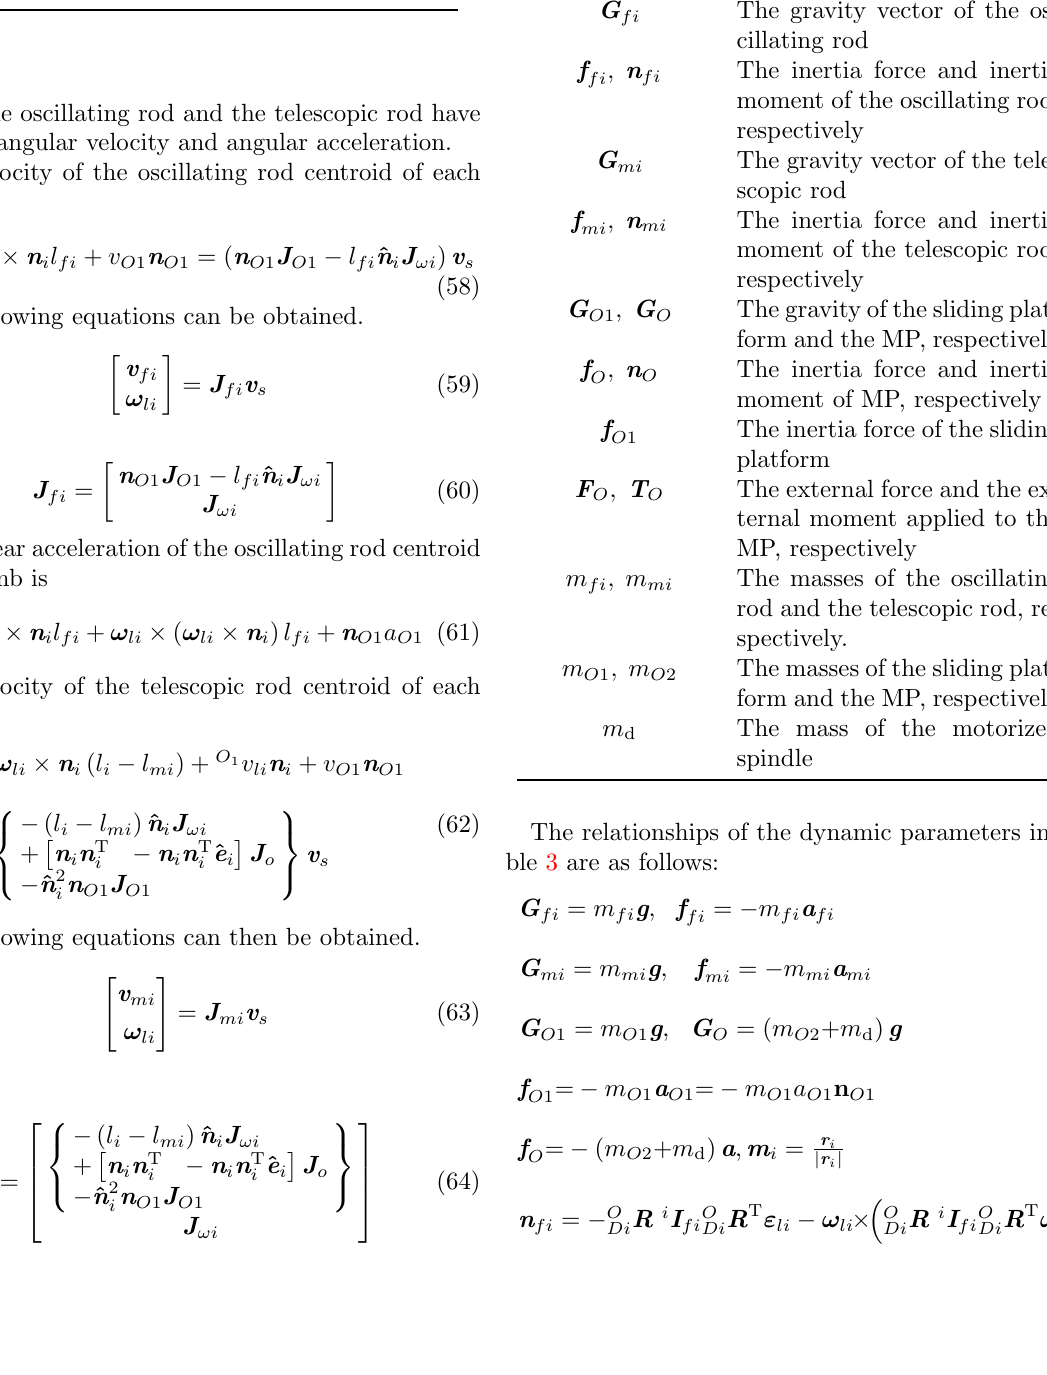
Table 2: The kinematic parameters of the oscillating rod and the telescopic rod ( i =1, 2, 3, 4) Parameters Description l fi distance from the oscillating rod centroid to the end of the limb l mi distance from the telescopic rod centroid to the end of the limb v fi , a fi velocity and acceleration of the os- cillating rod centroid, respectively v mi , a mi velocity and acceleration of the telescopic rod centroid, respec- tively